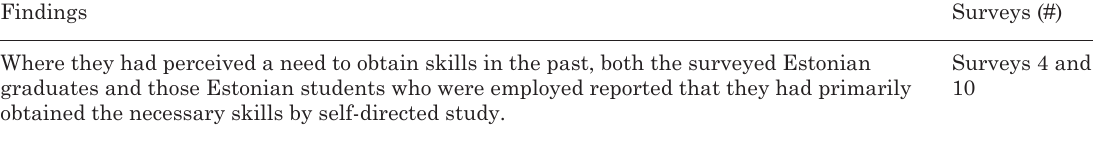
Table 3. Summarized findings relating to a distinction between a supply side and a demand side Findings